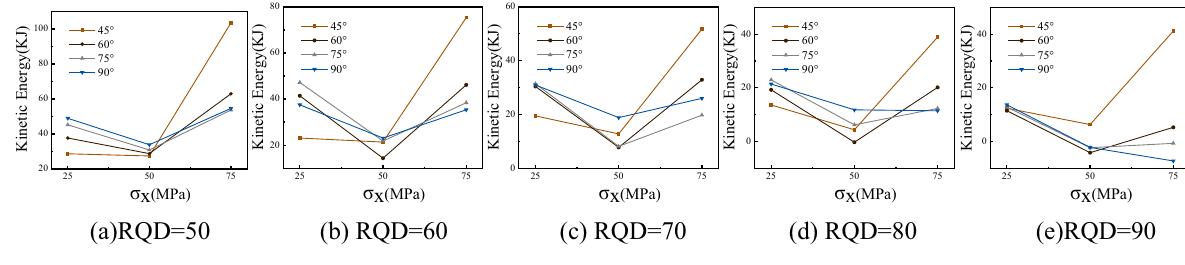
Fig. 29 KE' with different values of θ , RQD and σ